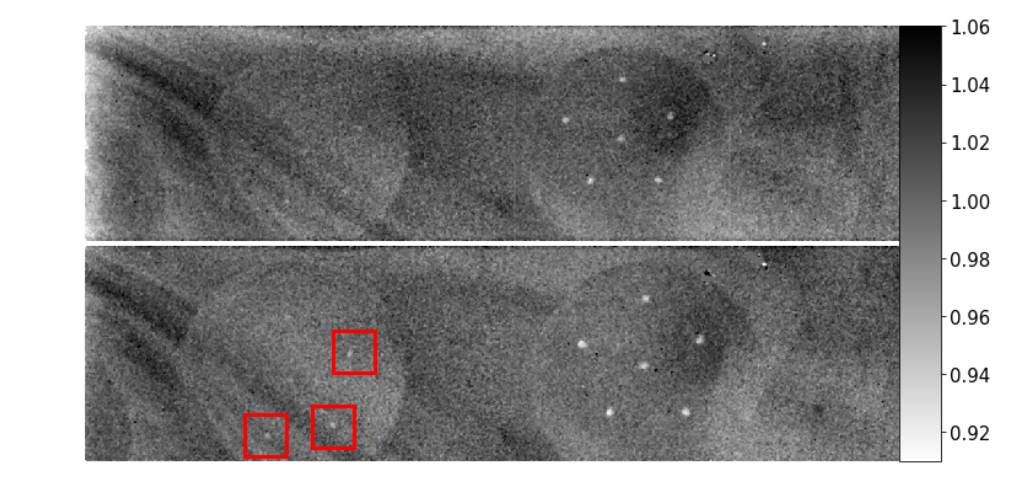
Figure 3. Projections of a CIRS breast phantom with embedded microcalcifications obtained at air gaps of ( top ) 1.2 cm and ( bottom ) 10.0 cm. Data for 20–30 keV energy